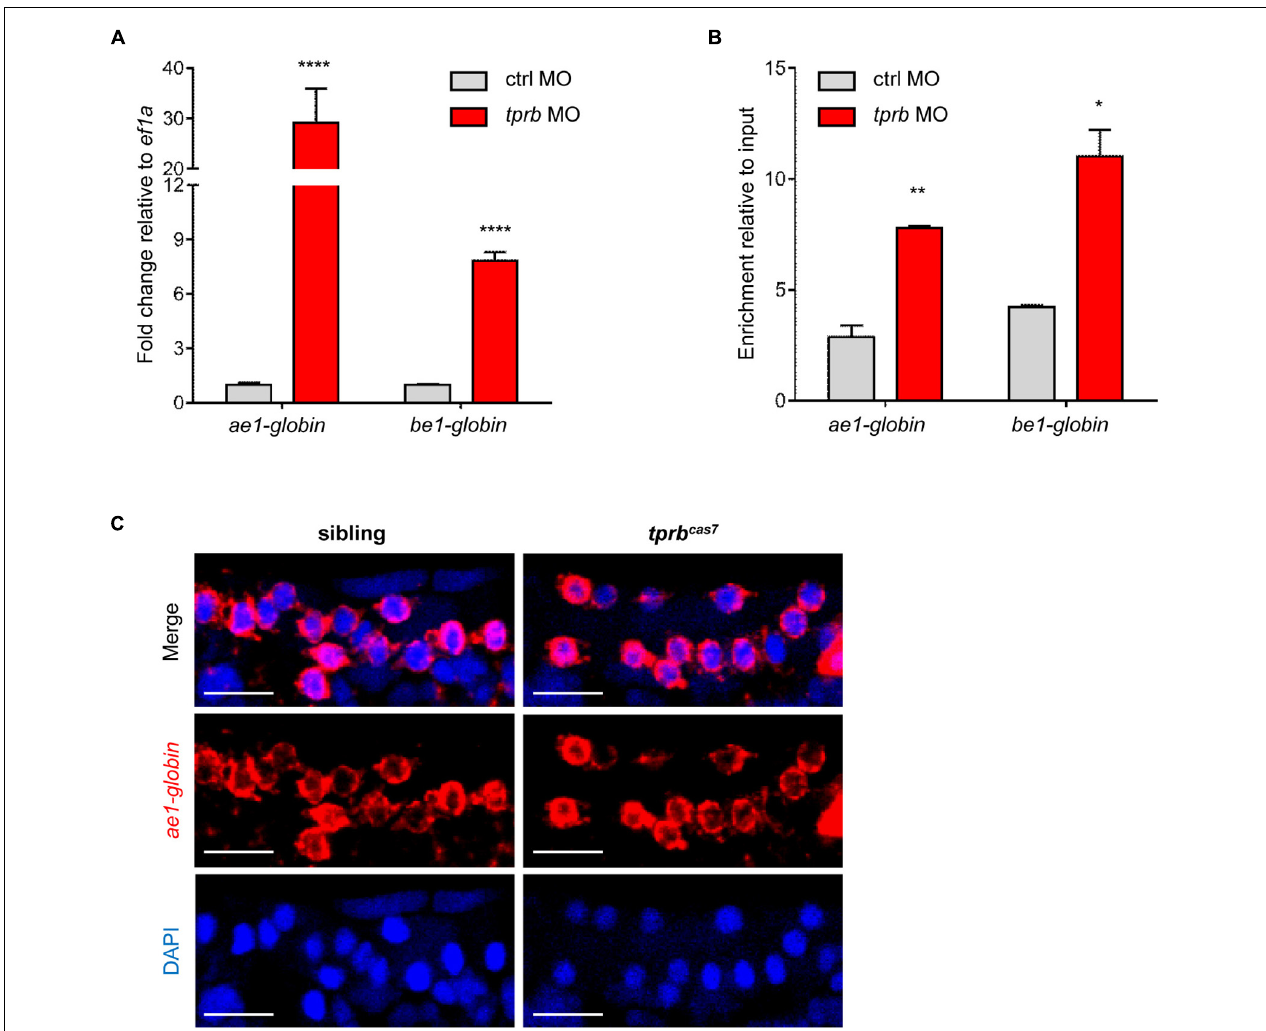
FIGURE 5 | tprb inactivation enhances the transcriptional activity of erythroid genes. (A) Quantitative PCR results of ae1-globin , be1-globin , and alas2 in erythrocytes after sorting an equal number of gata1 + cells in control and tprb morphants at 3 dpf. (B) Quantitative qChIP results of the binding enrichment of RNA polymerase II (Pol II) in ae1-globin , be1-globin , and alas2 after sorting equal number of gata1 + cells. (C) Fluorescence in situ hybridization (FISH) results of ae1-globin mRNA localization in sibling and tprb cas 7 mutants at 3 dpf. The nuclei were stained with DAPI (blue). Error bars represent SEM. N.S., not significant; * p < 0.05; ** p < 0.01; **** p < 0.0001. Scale bars represent 20 µ